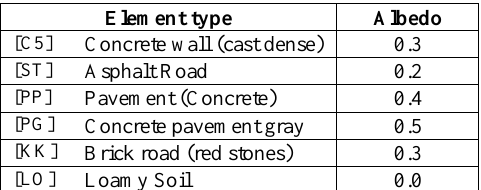
Table 3: Element types of build environment